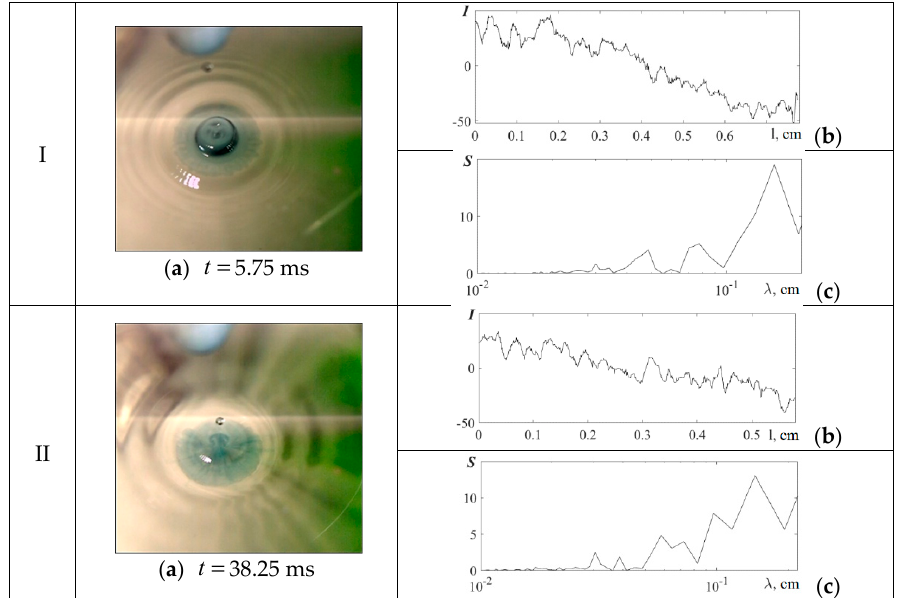
Figure 6. Azimuthally distributions of the colored area illumination of the drop coalescence patterns in selected frames I and II: (a) – frames at t = 5.75, 38.25 ms in Figure 5, (b) – illumination I , (c) – spatial spectra S .